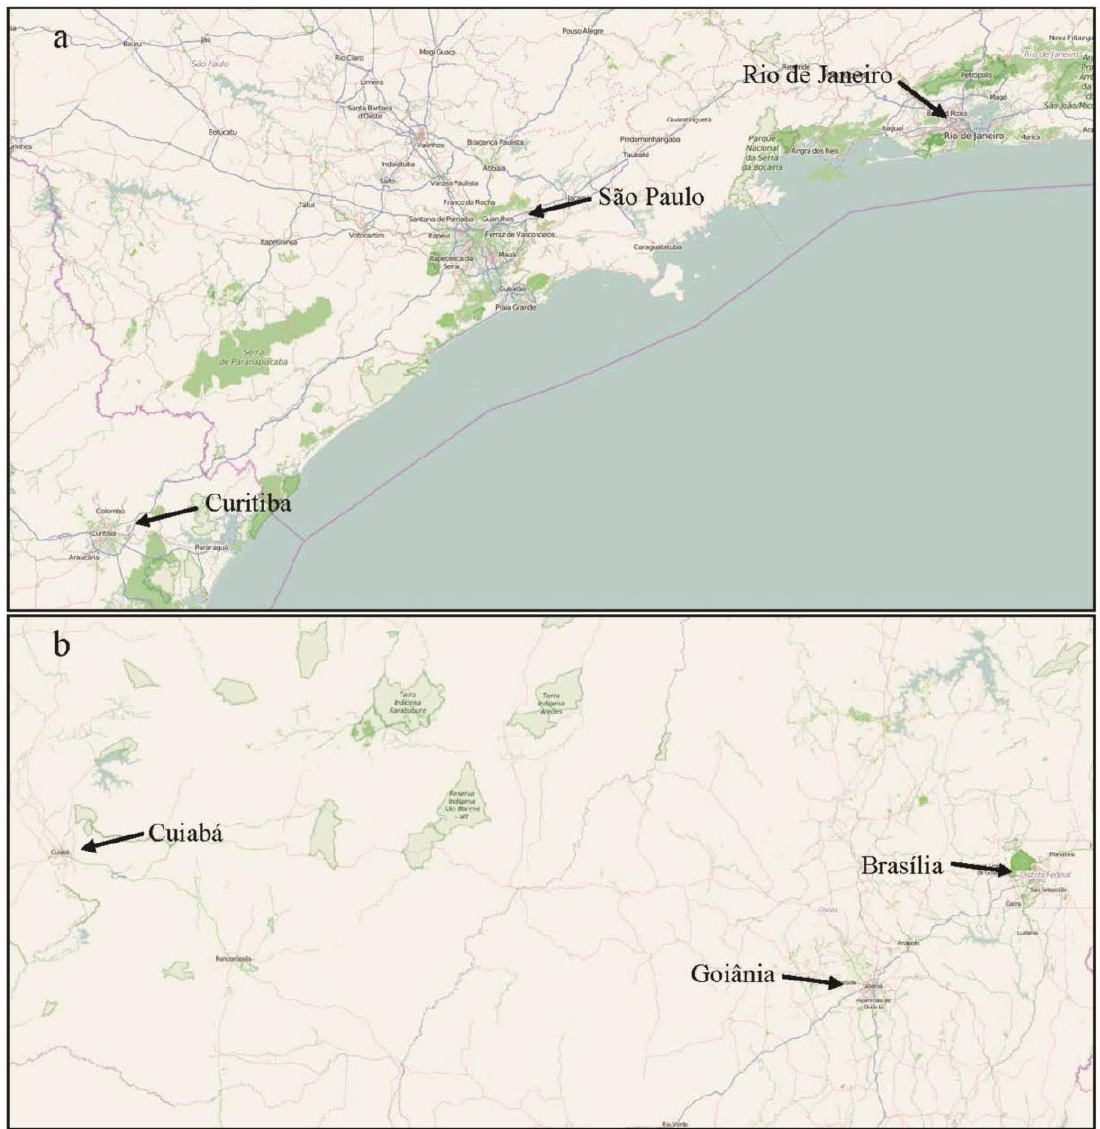
Figure 2. The first figure ( a ) shows an area with high urbanization level represented on OpenStreetMap, comprising the cities of Curitiba (South region of Brazil), São Paulo (Southwest region of Brazil), and Rio de Janeiro (Southwest region of Brazil). This first window (a) comprises over 25% of the total population of Brazil. In contrast, the second one ( b ) shows an area with a low level of urbanization—at the same scale as (a). This second and less populated area comprises two state capitals (Cuiabá and Goiânia) as well as the federal capital, Brasília. Looking at the pictures one can see the large difference between the amounts of features mapped in both cases. This is likely the result of the “segregation phenomenon” described by Haklay [21]. Source: Adapted from OpenStreetMap,